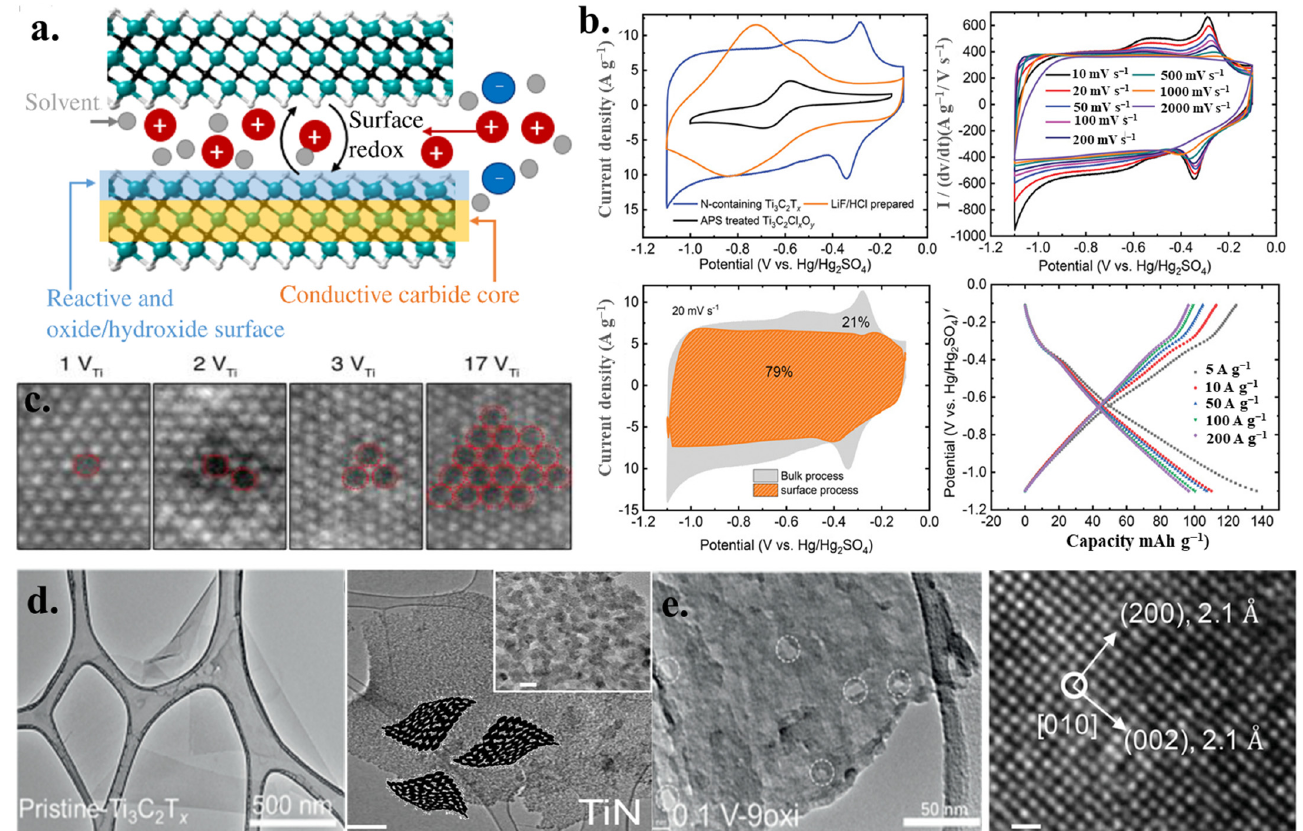
Figure 11. ( a ) An exemplification of MXene. ( b ) Charge storage rate [78]. ( c ) Dark-filed TEM [79]. ( d , e ) TEM image TM-nitride nanocrystals at 700 °C